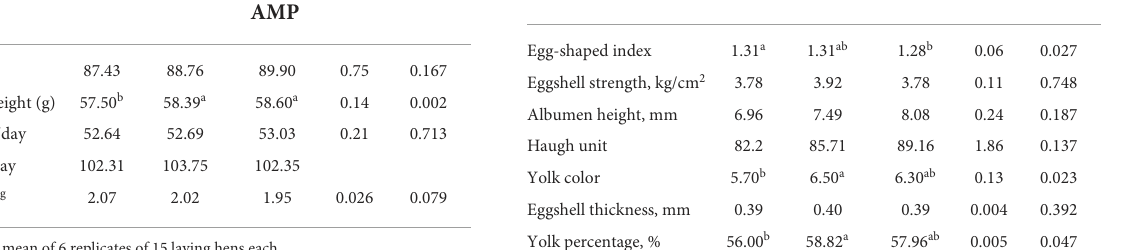
TABLE 4 Egg quality parameters of laying hens 1